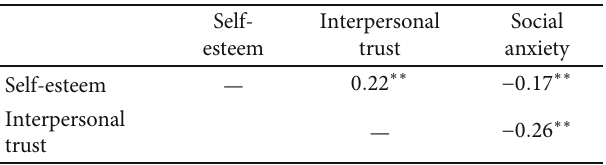
Table 2: Pearson ’ s correlation coe ffi cients between self-esteem, interpersonal trust, and social